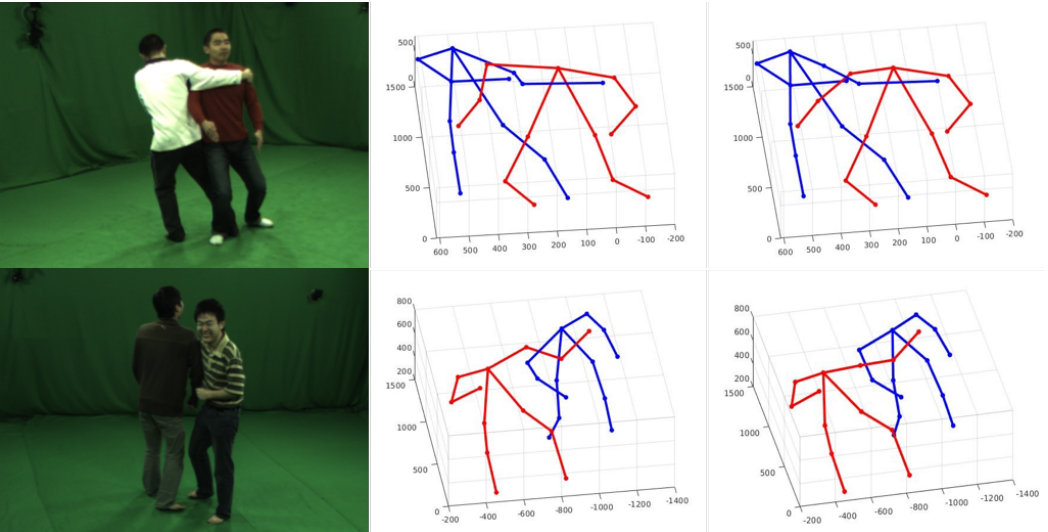
Figure 4. Comparison results for 3D pose detection without ( Middle ) and with ( Right ) interpenetration constrain O.